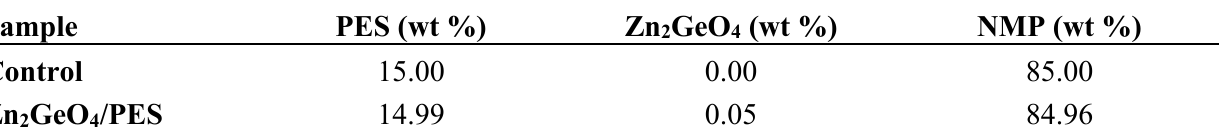
Table 3. Composition of membrane substrate.